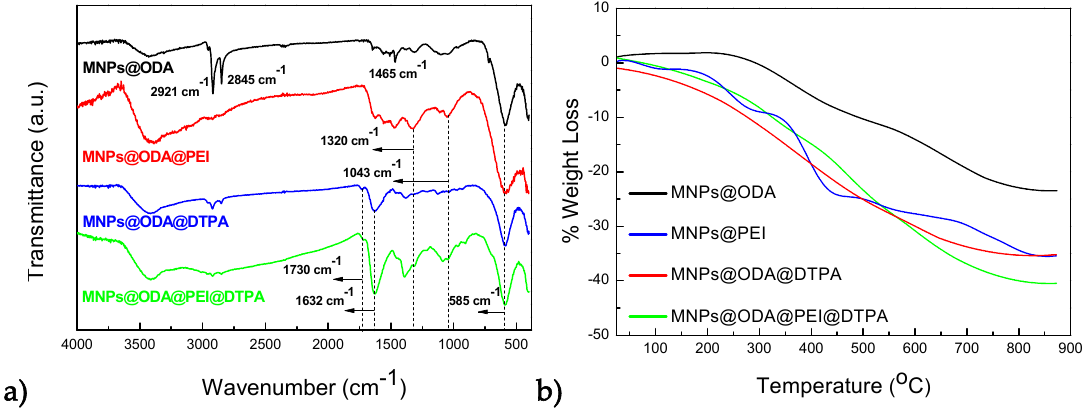
Figure 2. (a) FT-IR spectra of the primary MNPs@ODA together with the three surface-modified samples and (b) the weight loss of the organic amount under argon atmosphere of the four samples.